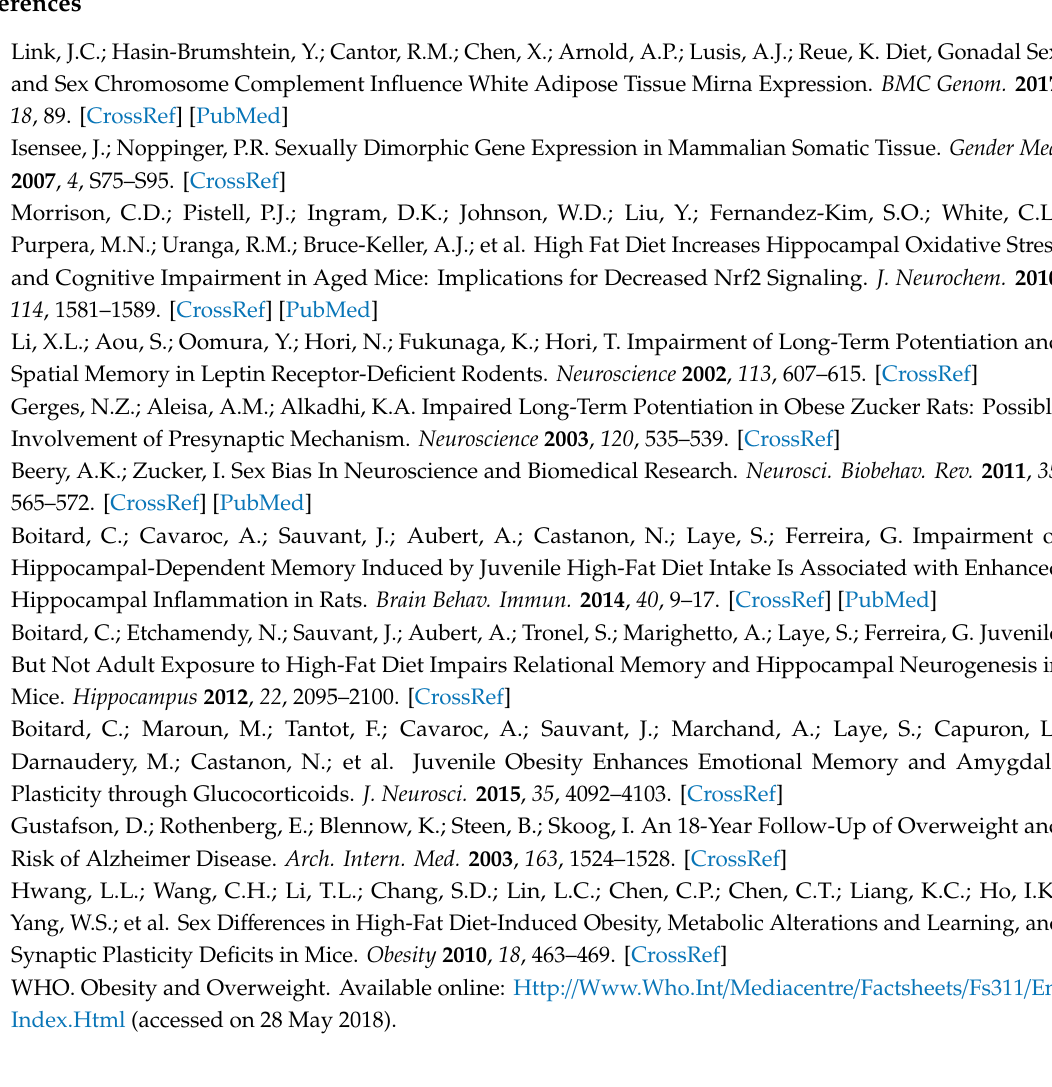
Figure S1: Analyses of systolic blood pressure, explorative behavior and spatial memory in young Ldlr- / -.Leiden male and female mice, Figure S2: Analyses of neuroinflammation and cerebrovasculature in hippocampal sections of young Ldlr- / -.Leiden male and female